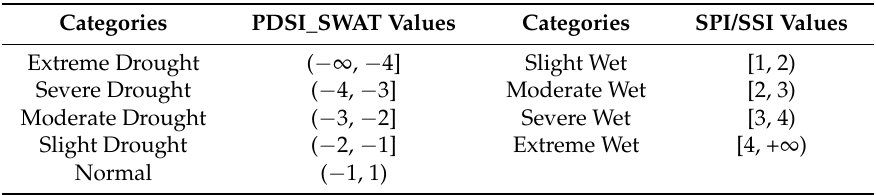
Table 3. The dry and wet classifications based on the Palmer Drought Severity Index coupled with the Soil and Water Assessment tool